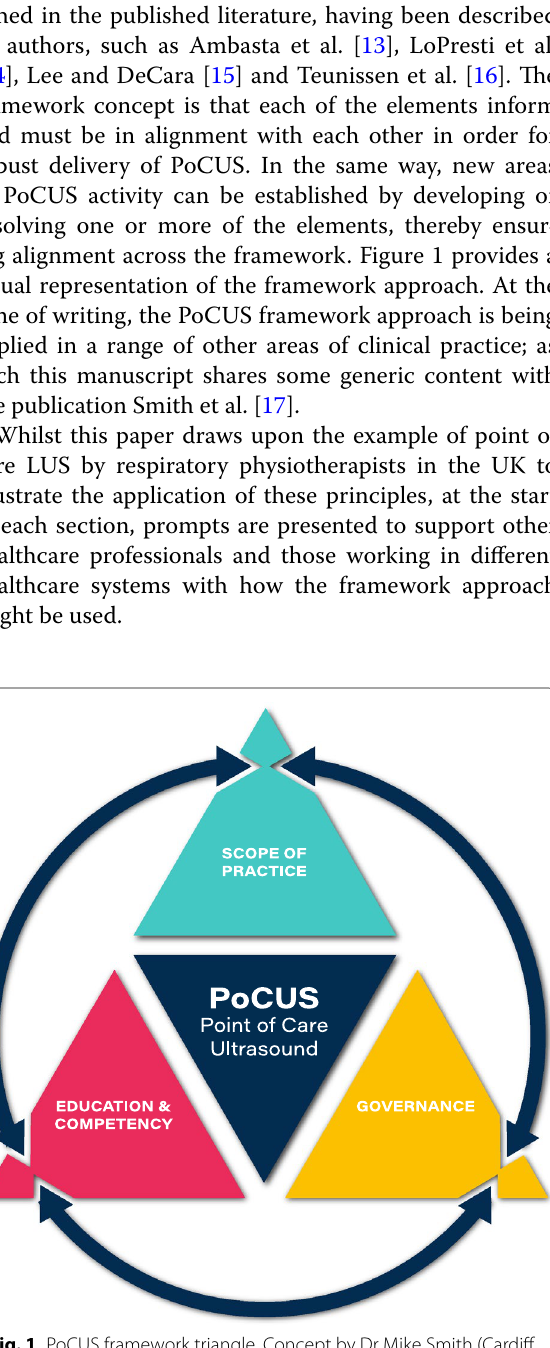
Fig. 1 PoCUS framework triangle. Concept by Dr Mike Smith (Cardiff University, UK), created by Dan Molloy (freshwater.media), copyright 2021 Dr Mike